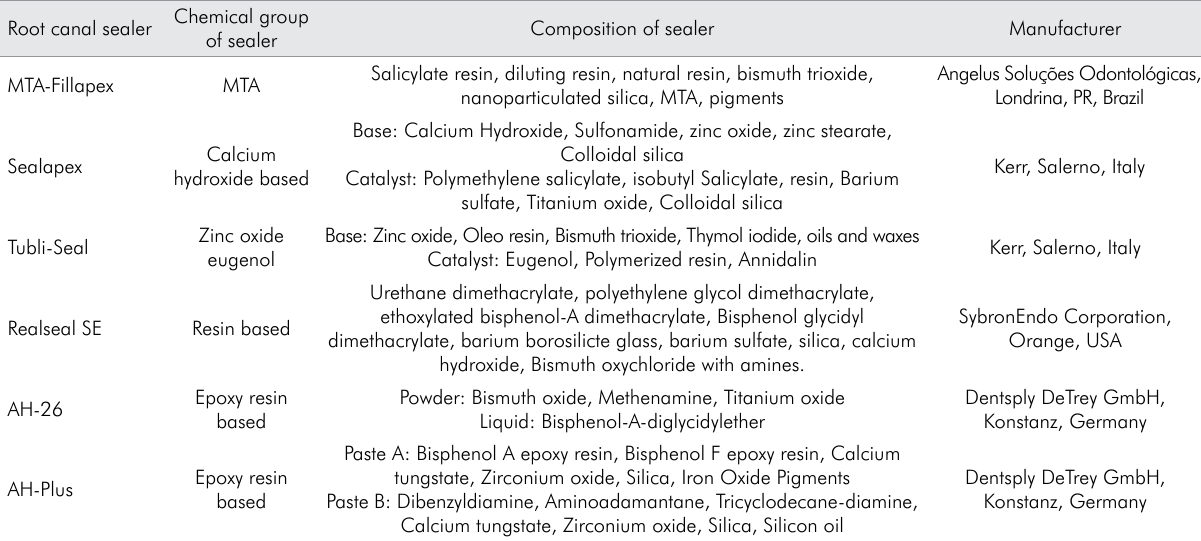
Table 1. Root canal sealers used in the